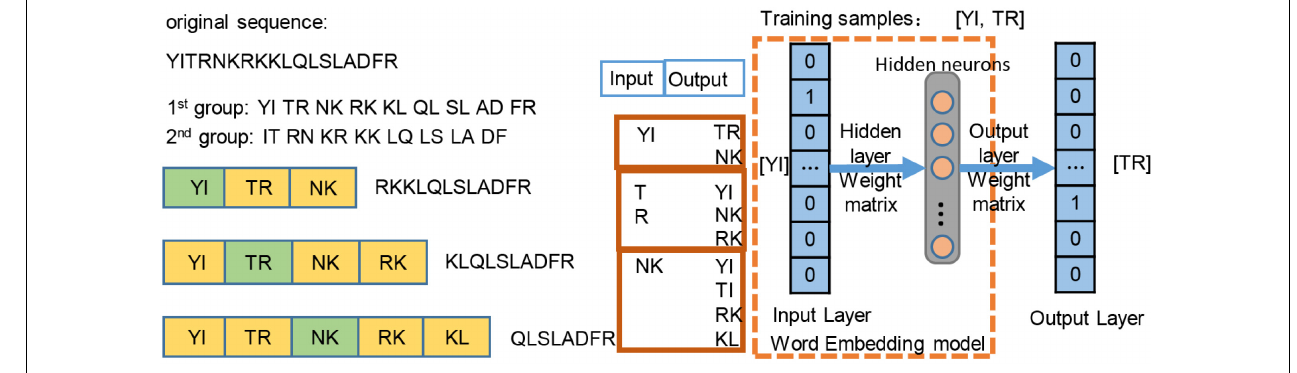
FIGURE 2 | Word2vec training process of the bigram